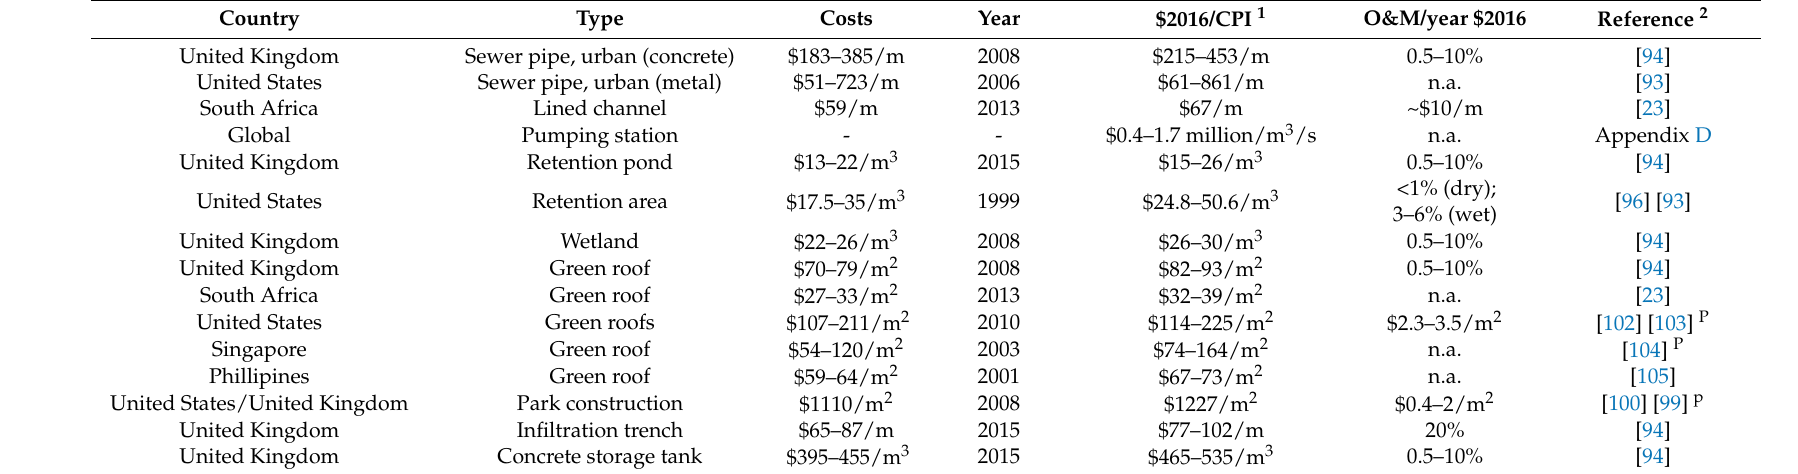
Table 8. Cost of measures against local